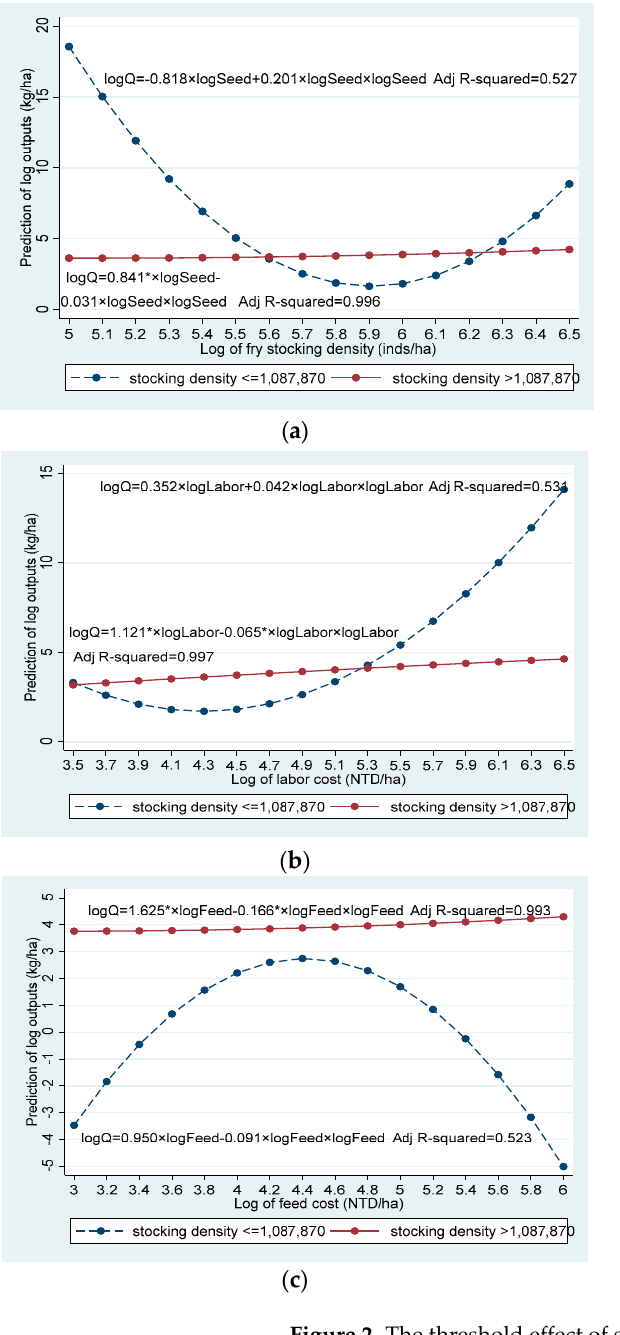
Figure 2. The threshold effect of stocking density on simulated hard calm productions with respect to control variables (Note: * significant at 5%; Source: Authors’ own calculations are based on the estimation of the threshold regression model). ( a ) Log of fry stocking density (inds/ha). ( b ) Log of labor cost (NTD/ha). ( c ) Log of feed cost (NTD/ha). ( d ) Log of other cost (NTD/ha). ( e ) Log of capital cost (NTD/ha).